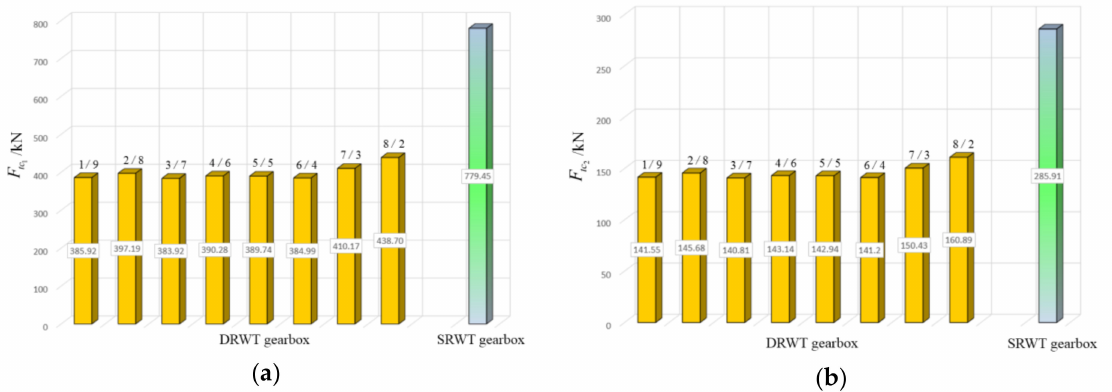
Figure 9. The tangential force on pitch circle of planet gear of DRWT and SRWT: ( a ) first planetary stage; ( b ) second planetary